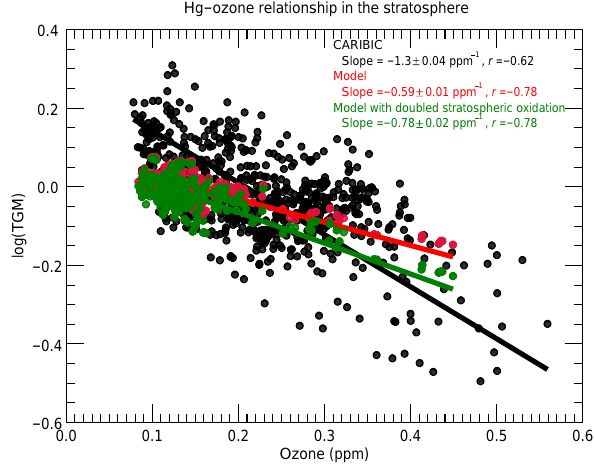
Figure 5. Relationship between total gaseous mercury (TGM) and ozone concentrations in the lower stratosphere. TGM is shown as the decimal logarithm of the concentration in units of ngm − 3 STP. Observations are from CARIBIC commercial air- craft in the extratropical Northern Hemisphere for April 2014– January 2015 (Slemr et al., 2015). Tropospheric data as diagnosed by [O 3 ] / [CO] < 1.25molmol − 1 are excluded. Model points are data for individual flights sampled along the CARIBIC flight tracks on the GEOS-Chem 4 ◦ × 5 ◦ model grid. Also shown are results from a model sensitivity simulation with a doubled Hg 0 oxidation rate in the stratosphere. Reduced-major-axis (RMA) regressions for the log(TGM)–ozone relationship are shown with slopes and cor- relation coefficients ( r ). Errors on the slopes are estimated by the bootstrap